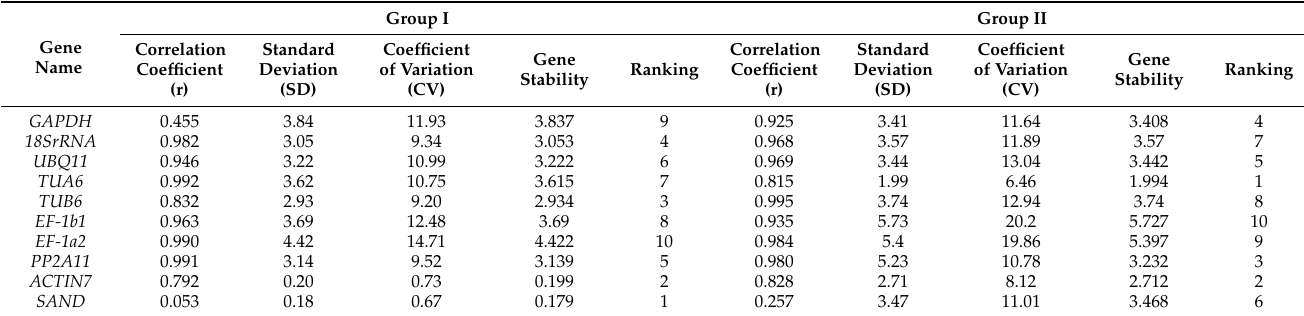
Table 3. Stability analysis of BestKeeper.